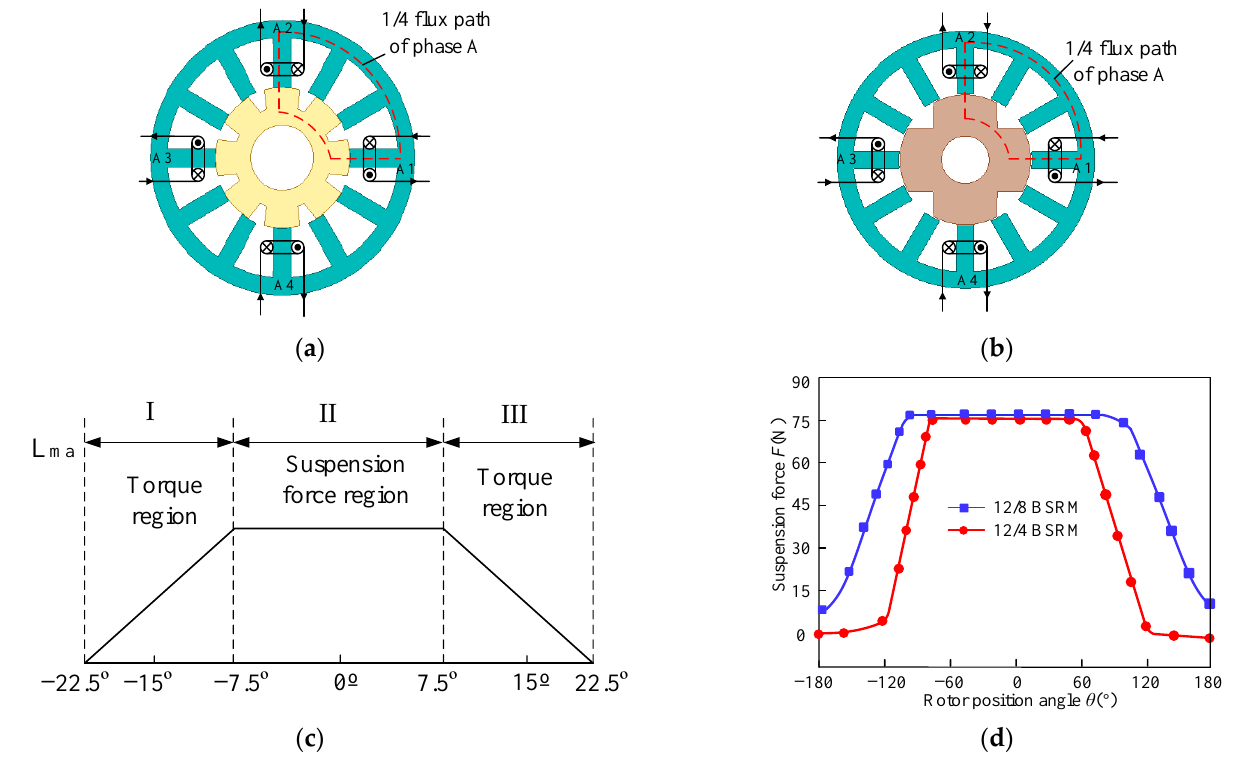
Figure 11. Wide rotor BSRM: ( a ) 12/8 pole; ( b ) 12/4 pole; ( c ) Winding inductance curve with two BSRMs; and ( d ) Suspension force F in α direction of the two BSRMs.